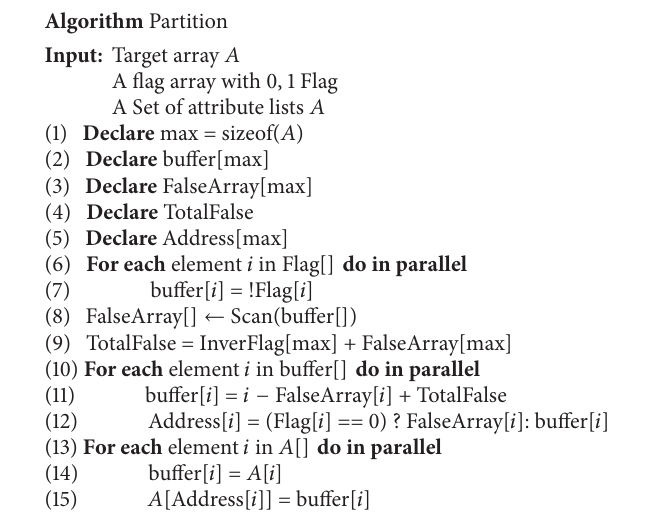
Algorithm 6: Algorithm of partition.